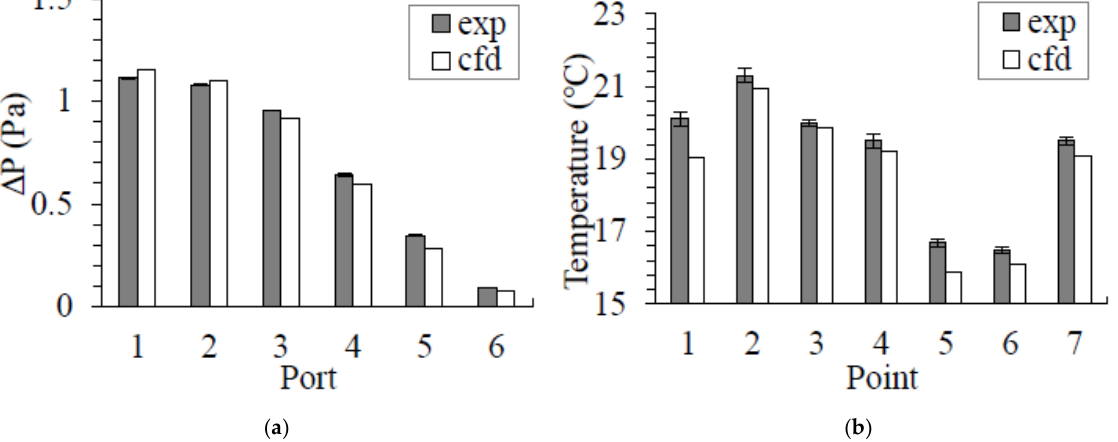
Figure 5. Comparison of CFD modeling results with measurement data: ( a ) pressure differences between Ports 1 to 6 with Port 7; ( b ) temperatures.